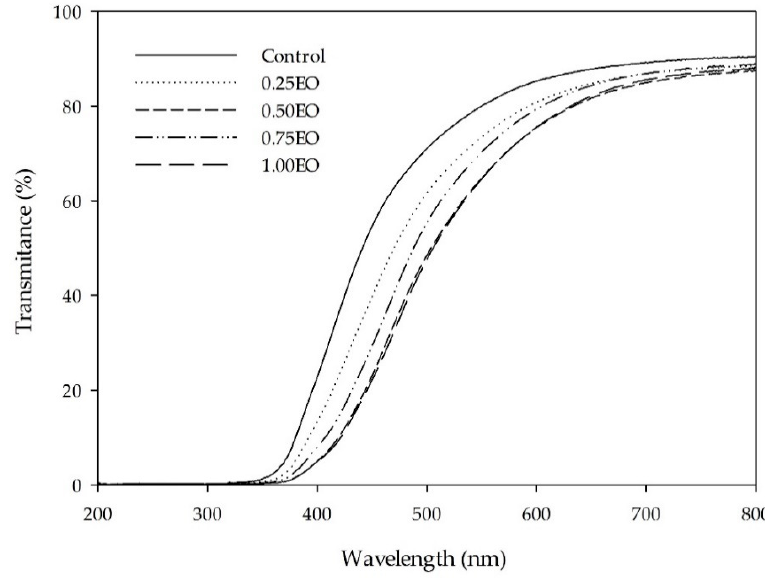
Figure 1. Light transmission of chitosan films with Citrus limonia essential oil.